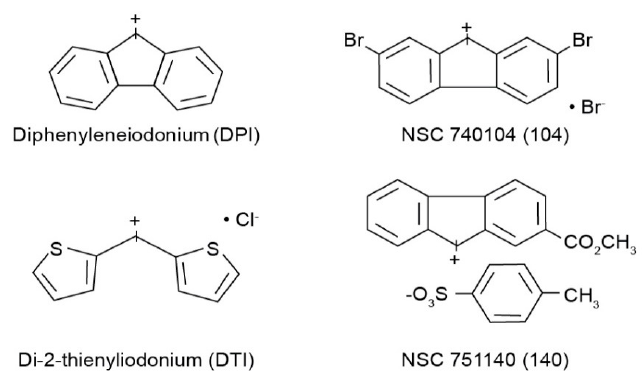
Figure 1. Structures of the four iodonium analogs examined in our experiments.